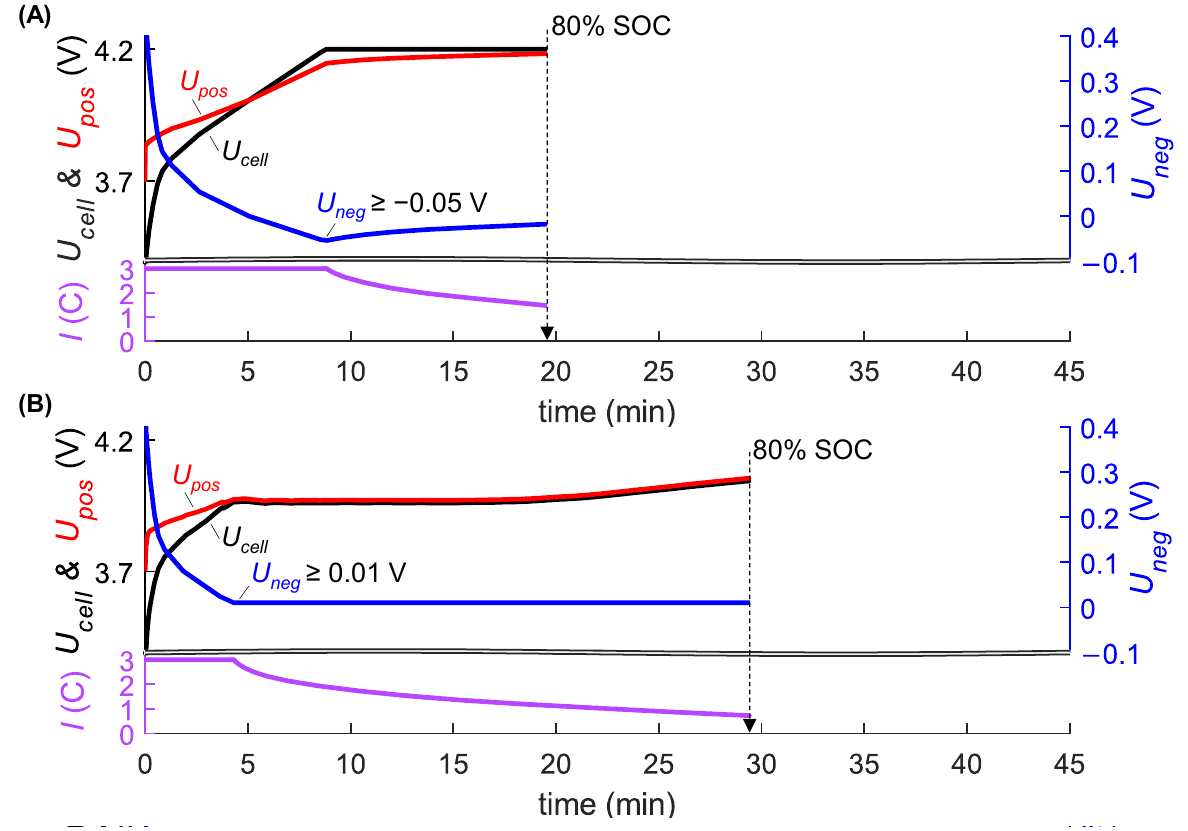
Figure 5. Comparison of the different fast-charging strategies and associated voltage curves. The voltages of both electrodes ( U pos and U neg ) are measured versus the lithium reference electrode, whereas the cell voltage ( U cell ) is the differential voltage of the electrodes. ( A ) The state-of-the-art fast-charging strategy 3C(CCCV) leads to negative voltages of the negative electrode. ( B ) Optimized fast-charging strategy 3C(EECM-opt) with 0.01 V minimum allowed voltage of the negative electrode. The 3C(EECM- opt) prevents negative voltages of the negative electrode, in order to prevent